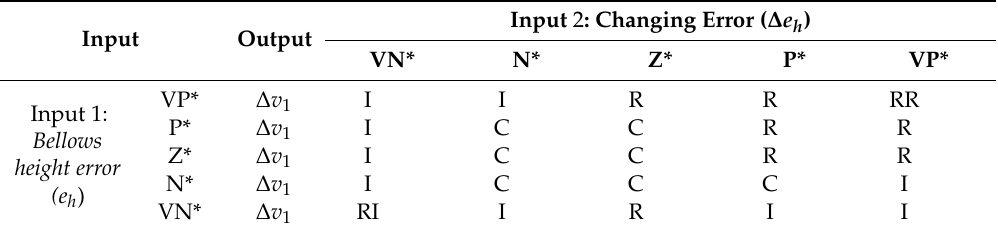
Table 2. Conventional fuzzy rules to determine the compression speed adjustment ∆ v 1 . (*Refer to Figure 12).